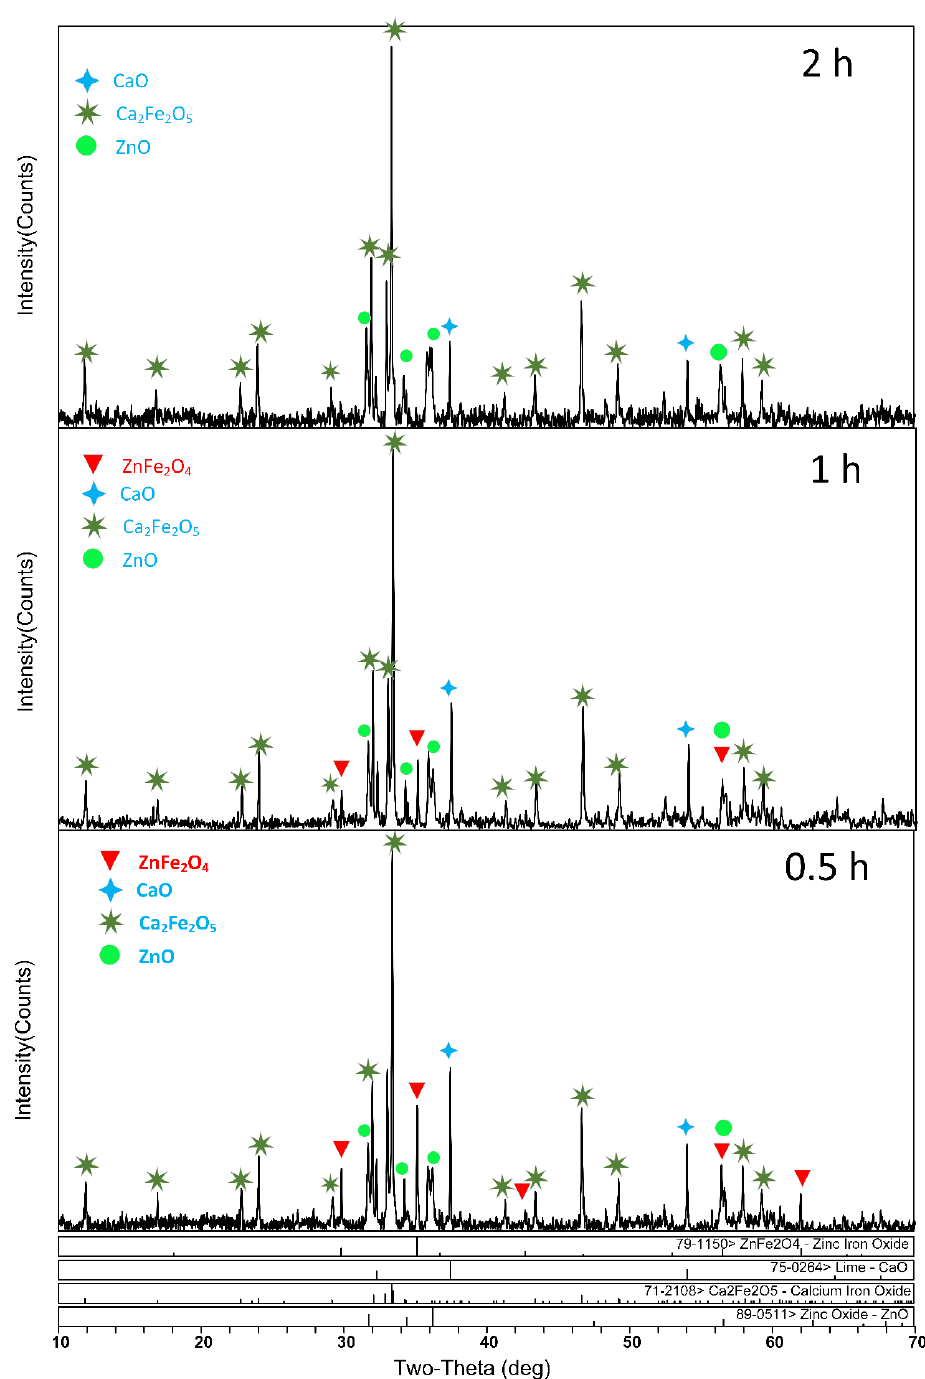
Figure 5. The XRD patterns of roasted samples under different roasting times. According to the phase transformation process of zinc ferrite with the addition of lime, it can be concluded that the formed calcium iron oxide is dicalcium ferrite (Ca 2 Fe 2 O 5 ).